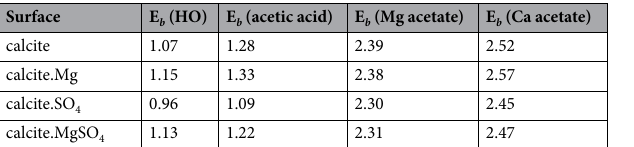
Table 1. Binding energies (eV) of water, acetic acid, Mg acetate and Ca acetate on pure calcite and modified calcite surfaces. The relative binding energy (i.e., the binding energy difference between water and oil molecule) is used in Eq. (3) to calculate the contact